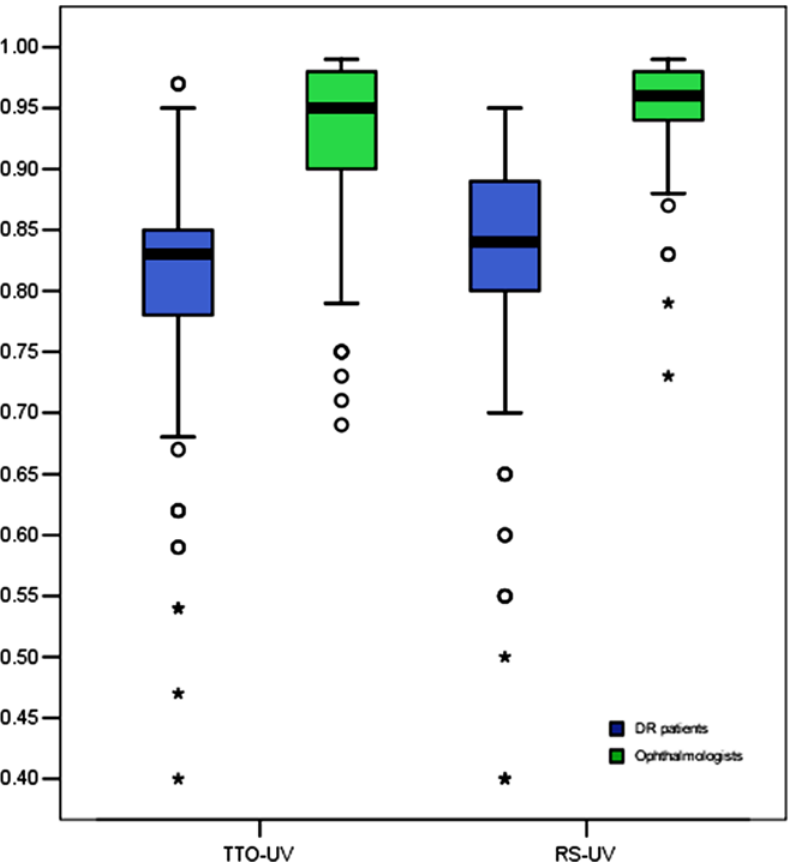
Fig 1. Distribution of utility values from diabetic retinopathy patients and ophthalmologists. The utility values were measured by time trade-off and rating scale methods. Boxes indicate the 25 th to 75 th percentiles of the utility values distribution, e.g., the interquartile range, and the bars inside the boxes represent the median. The whiskers extend to the lower and the upper extremes defined as 25 th percentile minus 1.5 times the interquartile range and the 75 th percentile plus 1.5 times the interquartile range. 〇 , mild outliers; * , extreme